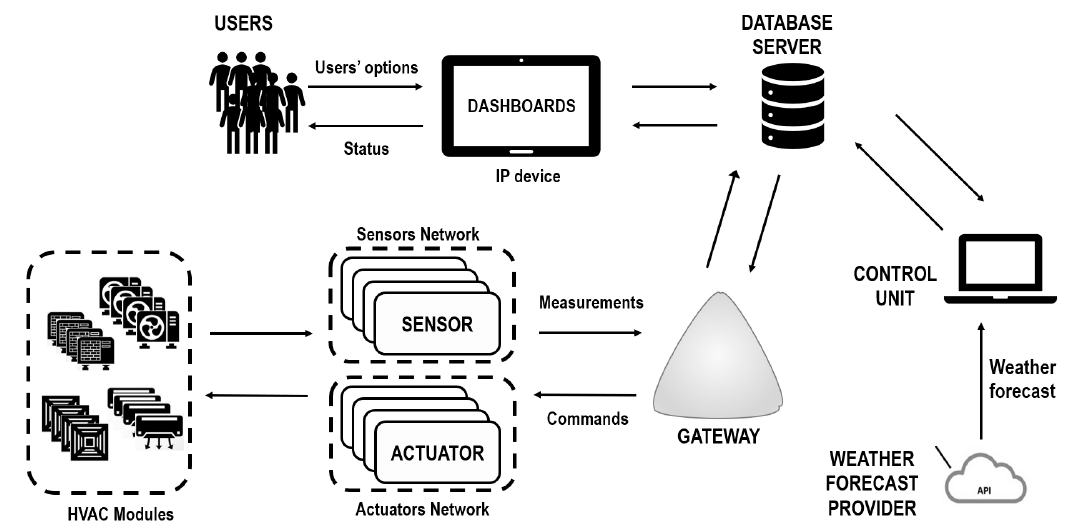
Figure 1. The high-level system diagram of the proposed IoT based